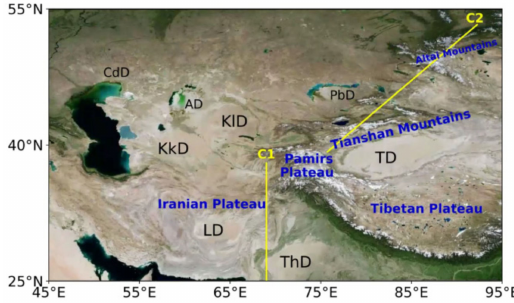
Figure 1. The geographical distribution of dust sources and major mountains in Central Asia. The dust sources include: the Lut desert, the Karakum Desert (KkD), the Kyzylkum Desert (KlD), the Aralkum Desert (AD), the Pre-Balkhash Desert (PbD), the Caspian Depression deserts (CdD), the Taklimakan Desert (TD) and, the Thar Desert (ThD). The downstream contribution of Central Asian dust will be estimated at two cross-sections (yellow lines) of C1 (~69 ◦ E) and C2 (along the Tianshan Mountains, the Junggar Xibu Shandi Mountains, the western of Altai Mountains),